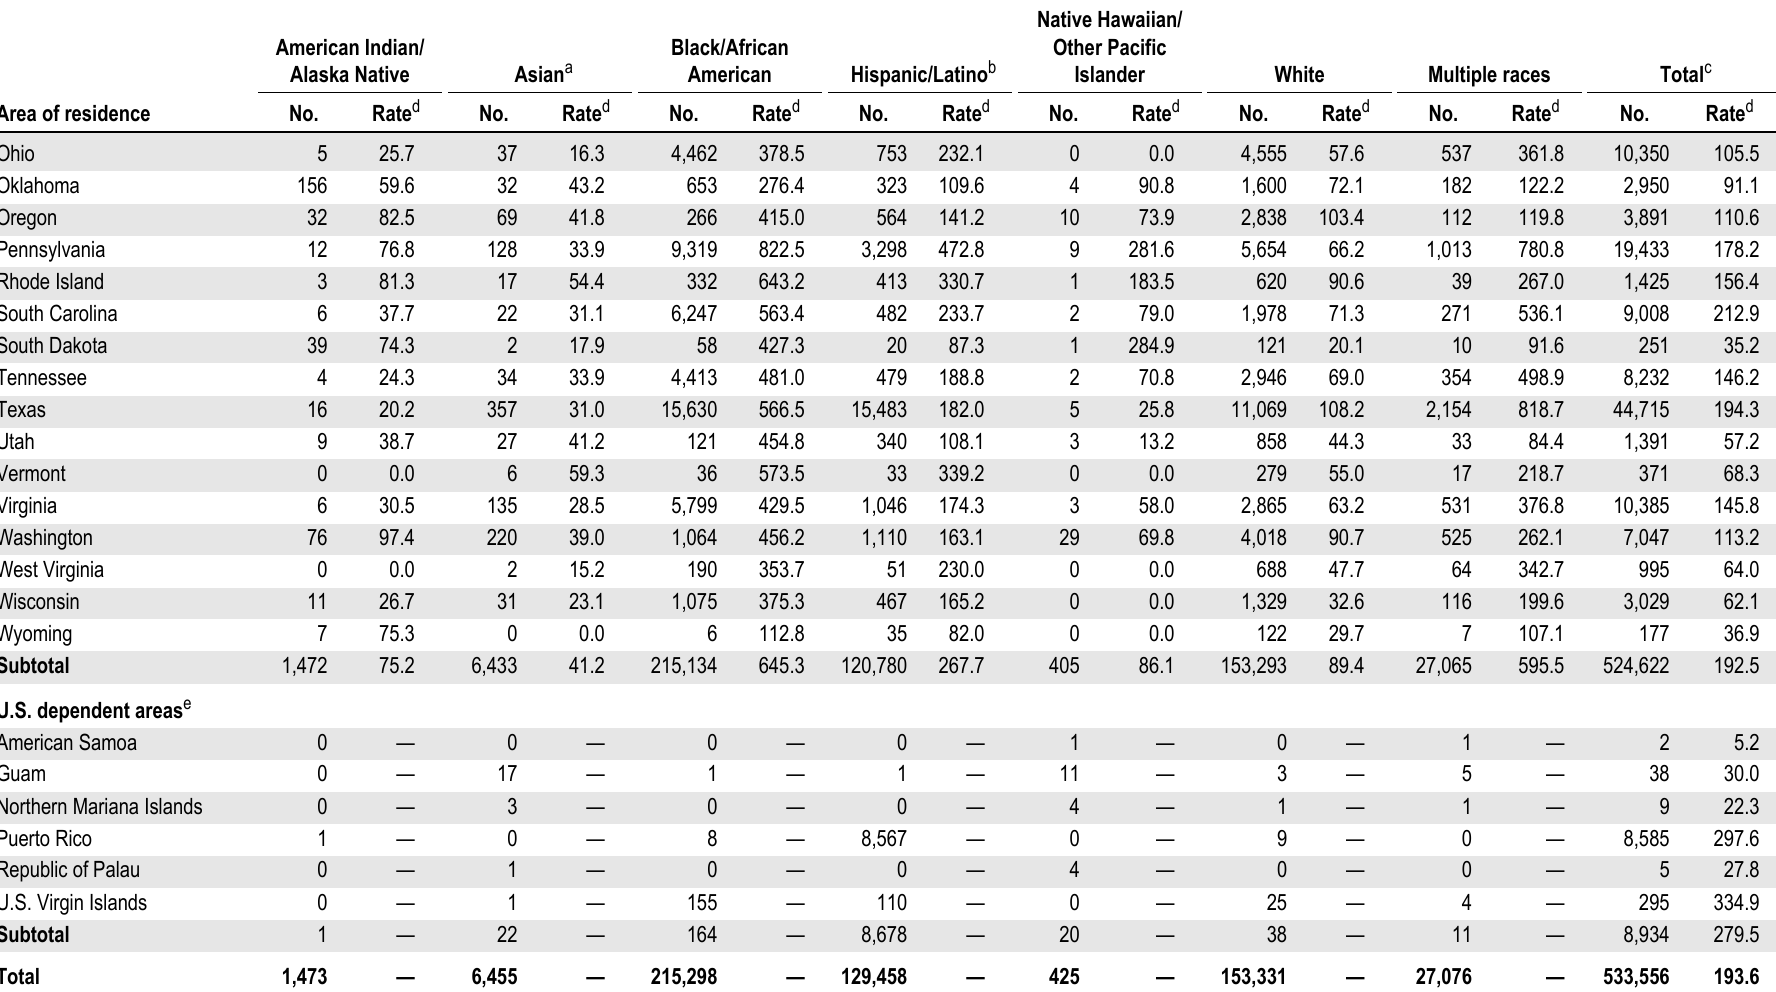
Table 29. Adults and adolescents living with diagnosed HIV infection ever classified as stage 3 (AIDS), by race/ethnicity and area of residence, year-end 2017—United States and 6 dependent areas